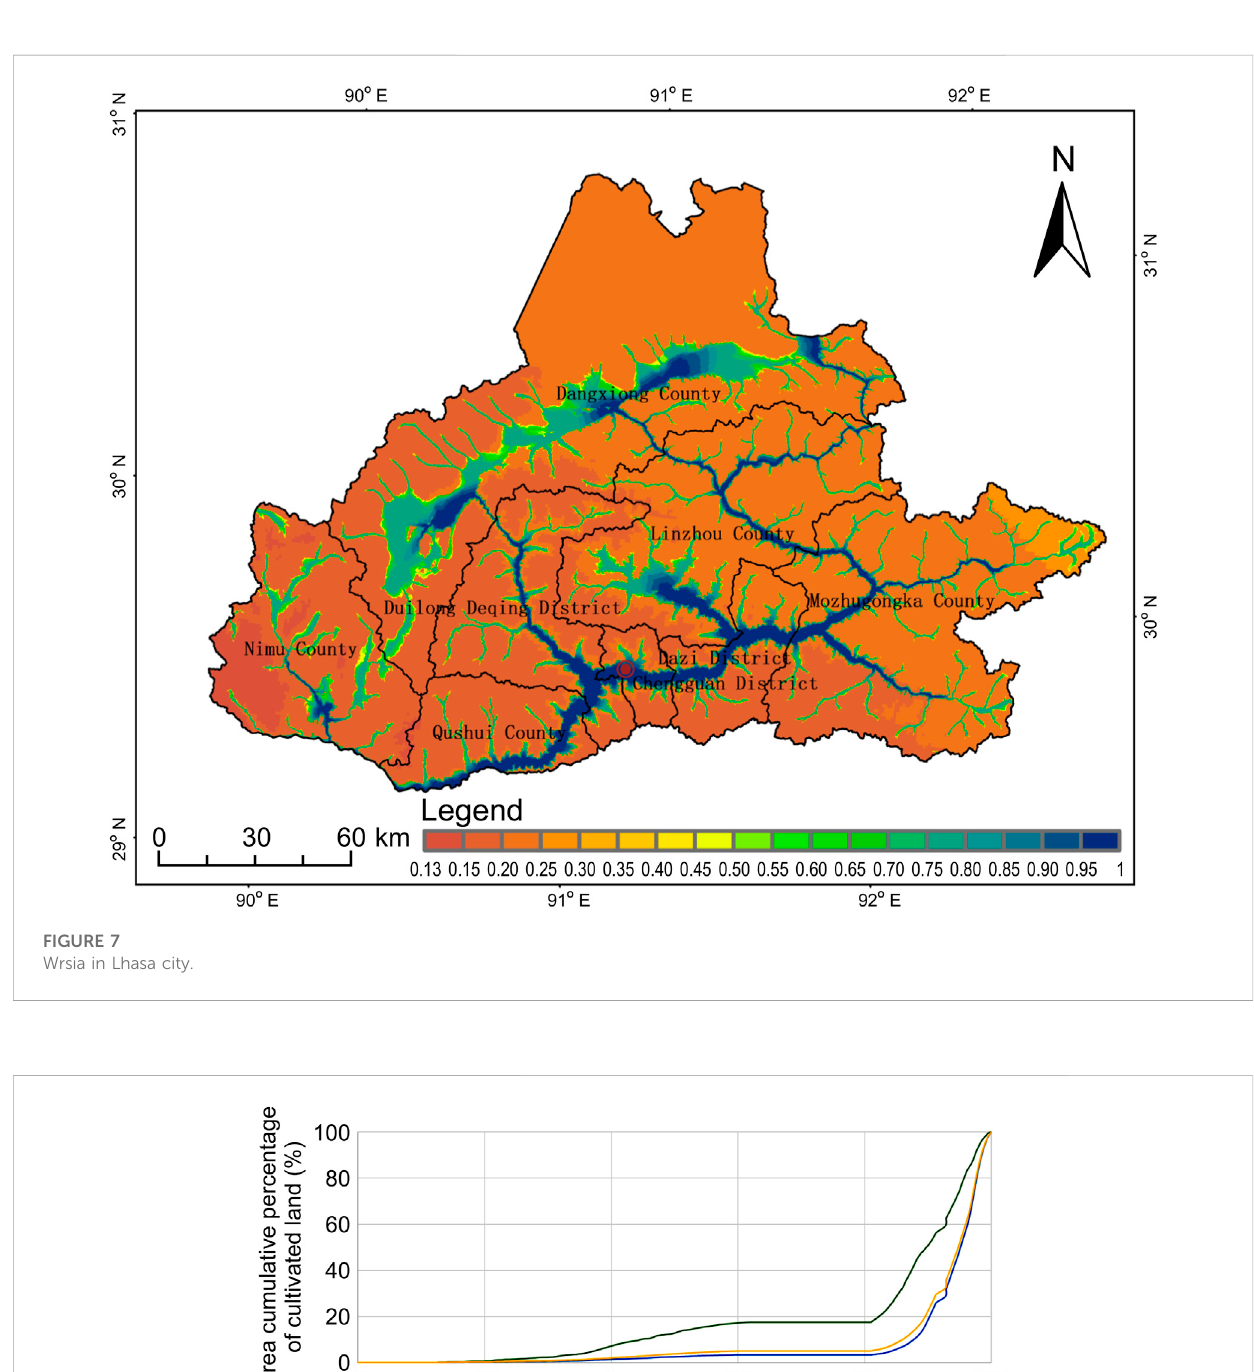
FIGURE 8 Double accumulation curve of WRSIA and cultivated